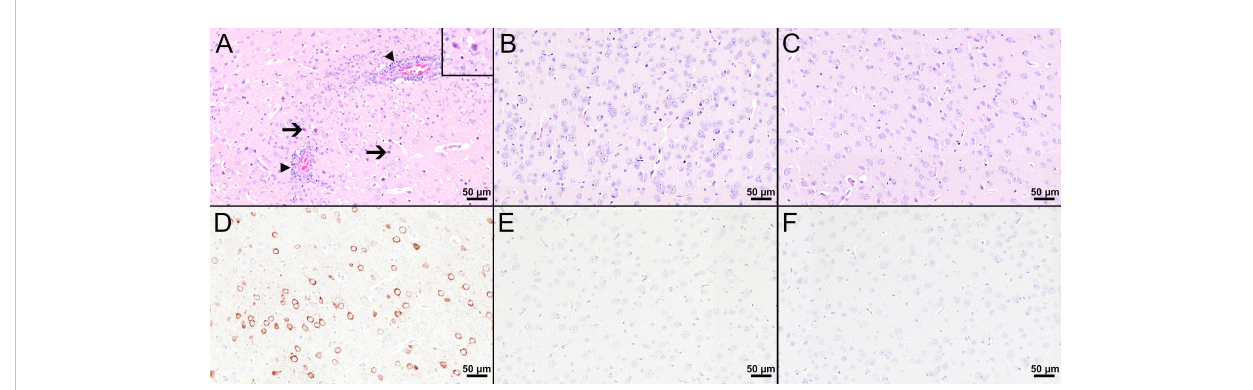
FIGURE 5 Histological and immunohistochemical analyses of the cerebral cortex at 8 dpi. (A – C) H&E-stained sections of the cerebral cortex of TBEV-infected mice which were either treated with PBS (A) or vaccinated with FSME-IMMUN ® (B) or MVA-prME (C) . (A) The cerebral cortex of the PBS-treated mouse displays cellular necrosis with karyorrhectic, karyolytic, and pyknotic cells (insert) and shrunken, hypereosinophilic, triangular-shaped necrotic neurons (arrows and insert) as well as in fl ammatory cell in fi ltrates in destructed vascular walls (necrotizing vasculitis; arrowheads) and the perivascular space (arrowheads). Microgliosis and hypertrophy of microglia/macrophages are present. (B, C) In FSME-IMMUN ® - (B) or MVA-prME-vaccinated (C) mice, no signi fi cant microscopic lesions within the cerebral cortex parenchyma are visible. (D – F) IHC for the TBEV E antigen of the cerebral cortex of TBEV-infected mice which were either treated with PBS (D) or vaccinated with FSME-IMMUN ® (E) or MVA-prME (F) . (D) Immunohistochemically, a cytoplasmic TBEV immunoreactivity is present in multiple cells representing neurons of the cerebral cortex from a PBS-treated mouse. (E, F) The cerebral cortex of FSME-IMMUN ® - (E) and MVA-prME-vaccinated (F) mice lack immunoreactivity. Scale bars: 50 µM.